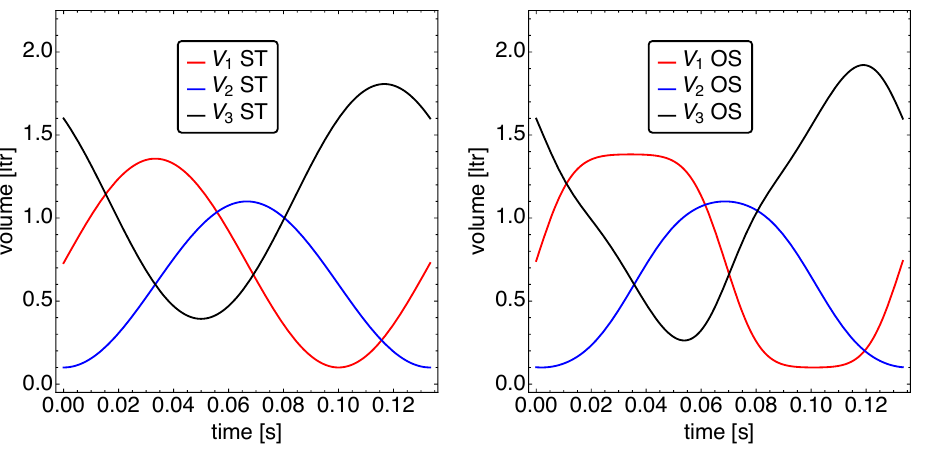
Figure 9. The volume of reservoirs 1, 2, and 3 vs. time during one cycle at 450rpm for ST motion ( left ) and OS motion ( right ). Comparing the respective trajectories, one sees that the trajectory of the hot regenerator shows a more square-like shape, while the trajectory of the cold regenerator is still close to a sinusoidal